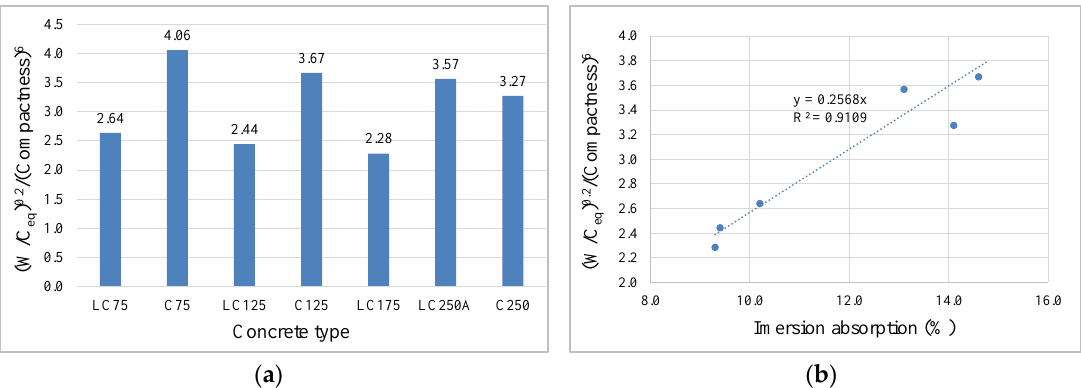
Figure 13. Relation between W/C eq ( a ) and compactness depending on water absorption by immersion ( b ).